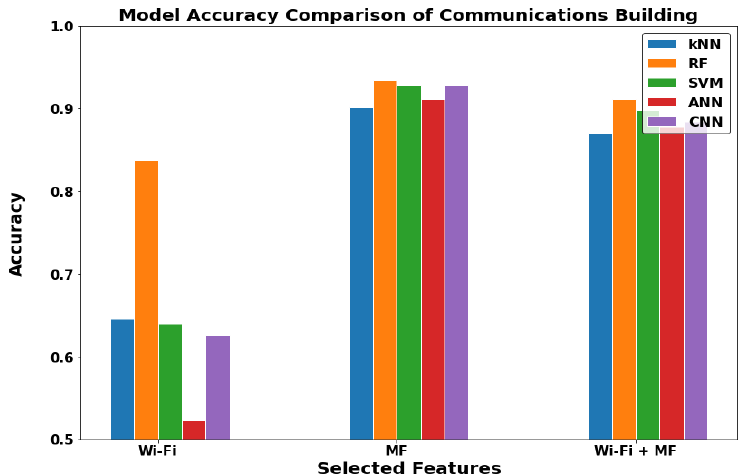
Figure 15. The models comparison in Communications department building (Outdoor).